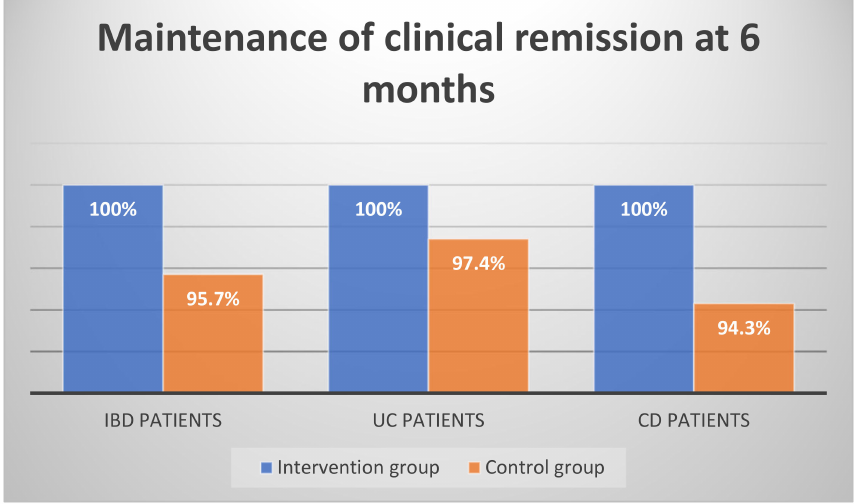
Figure 1. Maintenance of clinical remission 6 months after